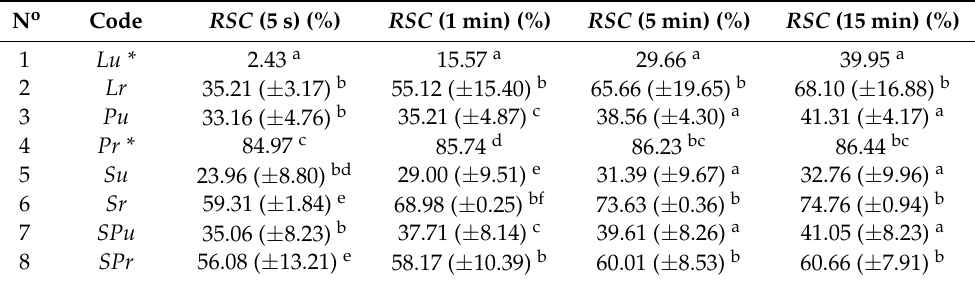
Table 1. Antioxidant activity results ( RSC —radical scavenging capacity, %, at various reaction times) for papaya extracts (unripe and ripe, various parts; peel— Lu and Lr , pulp— Pu and Pr , seed— Su and Sr , seed-pulp— SPu and SPr ). Values are expressed as mean ( ± standard deviation, SD), excepting * for single analysis. For a given parameter ( RSC ), values with different superscript letters are significantly different, according to Fisher LSD (least significant difference) test ( p < 0.05). All p -level values are presented in the Supplementary Material